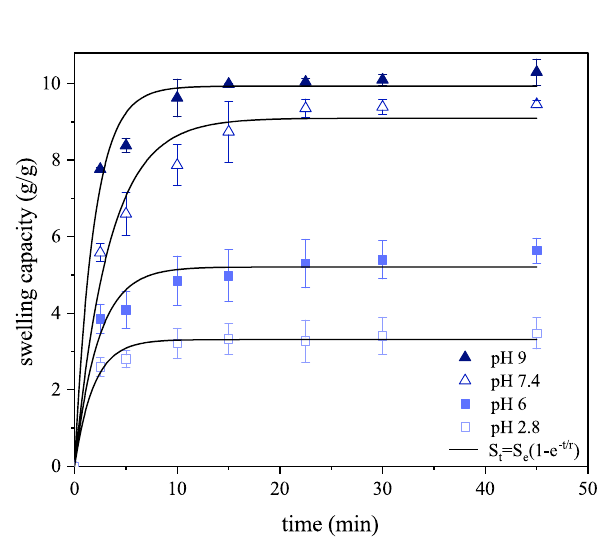
Figure 6. Plot of swelling capacity vs time. With use of Eq. (2), swelling rate ( S t ) of the BC-based CH was obtained for the test